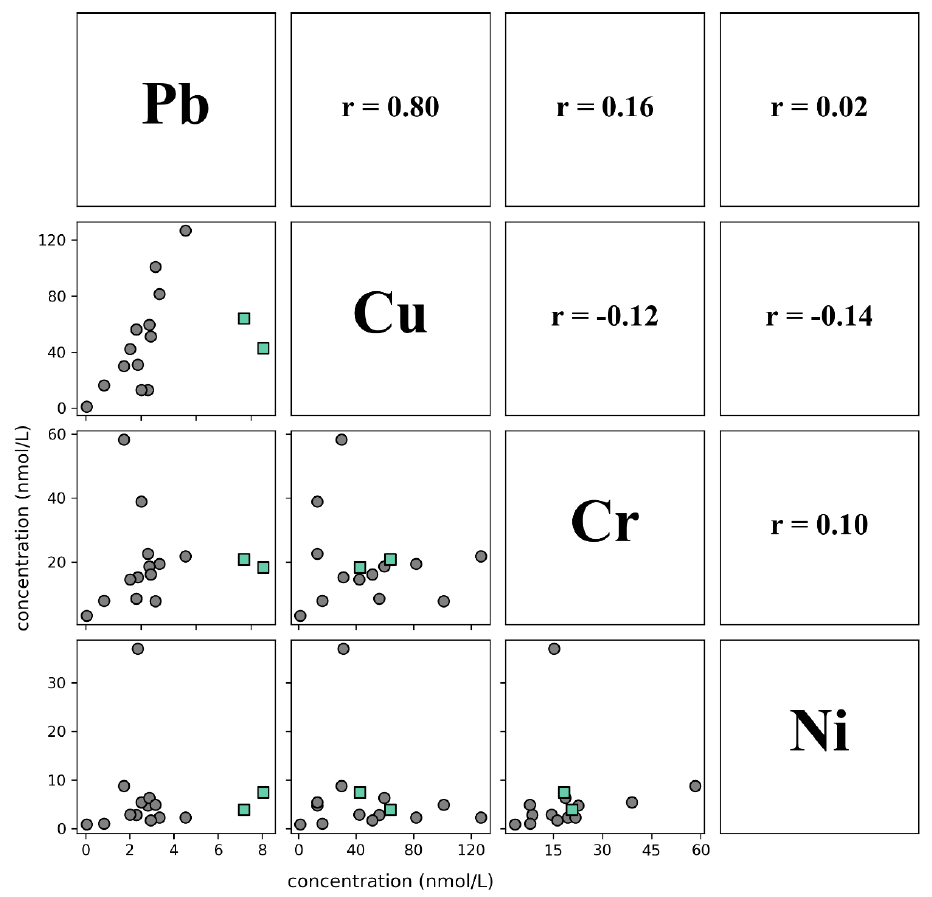
Figure 7. Scatterplot matrix displaying correlation of heavy metal elements in groundwater. Teal squares highlight the two samples in which elevated Pb concentrations were measured (ILI-84, TAF-171). Data are in Table 1.